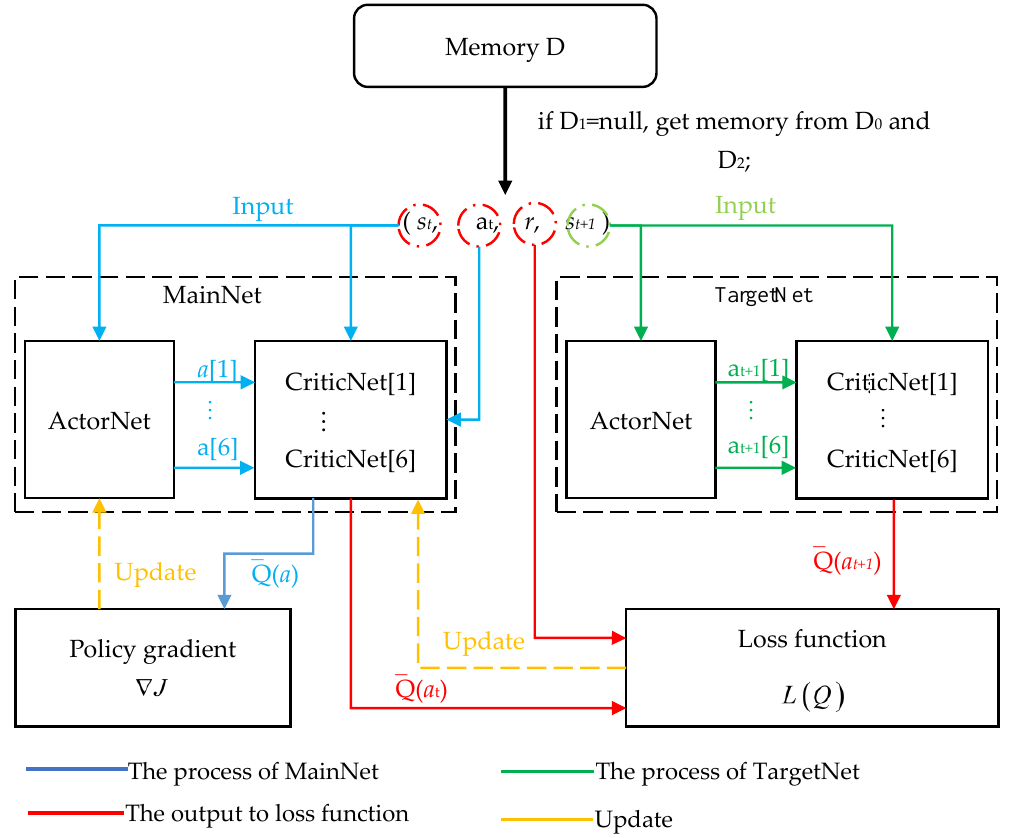
Figure 2. The improved deep deterministic policy gradient (DDPG) algorithm.